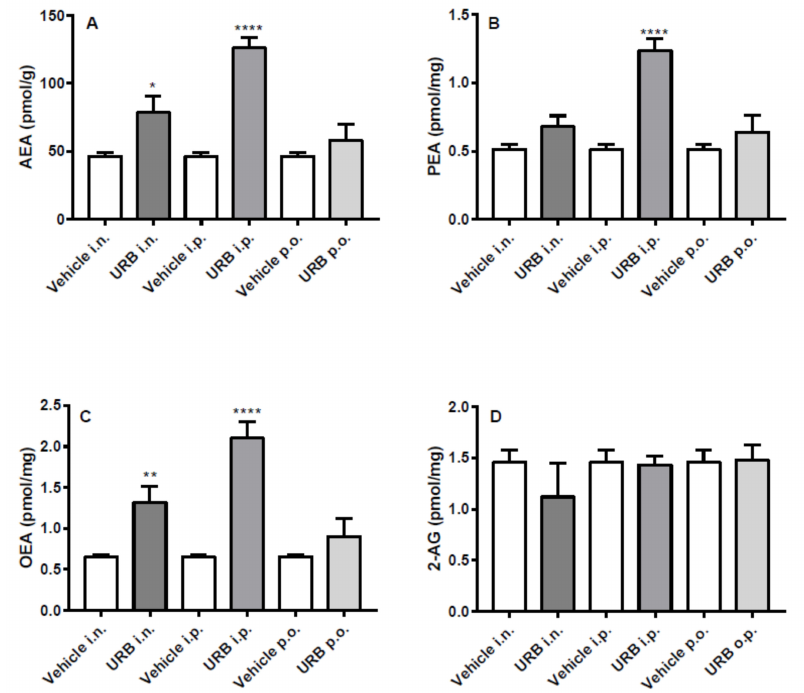
Figure 3. E ff ect of in vivo URB administration on hippocampal levels of NAEs and 2-AG. Levels of ( A ) AEA, ( B ) PEA, ( C ) OEA and ( D ) 2-AG following URB or vehicle (i.n., i.p. or p.o.) administration. Data are presented as mean ± SEM expressed as pmol per gram or milligram of wet tissue. * p < 0.05, ** p < 0.01 and **** p < 0.0001 post hoc comparisons with vehicle conditions, Tukey’s